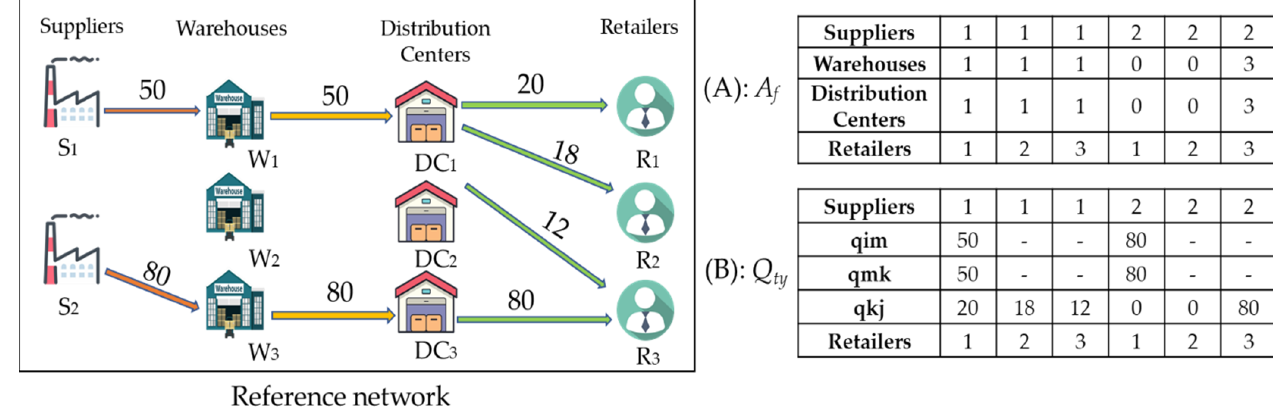
Figure 4. Illustration of the proposed coding.